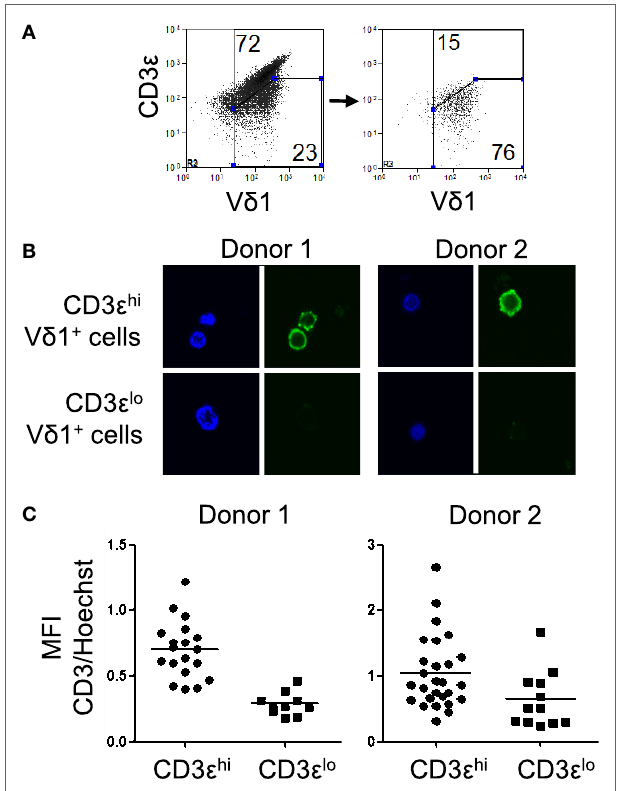
FigUre 3 | CD3 ε lo V δ 1 T cells express very low levels of intracellular CD3 ε . V δ 1 T cells were purified from two independent blood donors and sorted using a flow cytometric cell sorter into cells with high and low surface expression of CD3 ε . The cell populations were incubated on poly l -lysine- coated glass chamber slides, fixed, permeabilized, and blocked with BSA. The samples were then incubated overnight with a FITC-conjugated mouse anti-human CD3 ε antibody, washed twice, and counter-stained with Hoechst 33258 to visualize the nuclei. The slides were then imaged under oil immersion with a laser scanning confocal microscope and mean fluorescence intensity (MFI) was quantified. (a) Flow cytometry dot plots showing CD3 ε and V δ 1 T cell receptor expression by a line of expanded V δ 1 T cells (left) and sorted CD3 ε lo V δ 1 T cells (right). (B) Confocal micrographs showing CD3 ε (green) and nuclei (blue) in sorted CD3 ε hi (top) and CD3 ε lo (bottom) V δ 1 T cells from two donors. (c) Scatter plots showing the ratios of MFI of CD3 to Hoechst staining in individual cells from the sorted populations of CD3 ε hi and CD3 ε lo V δ 1 T cells from two donors.